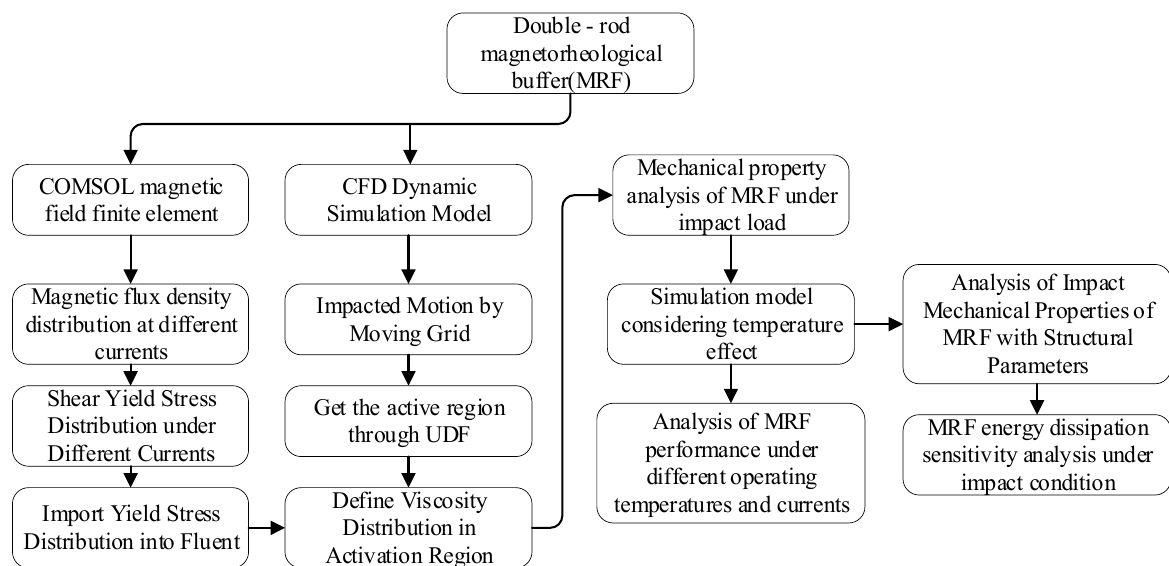
Figure 9. Diagram of magnetic field and flow field coupling technology.